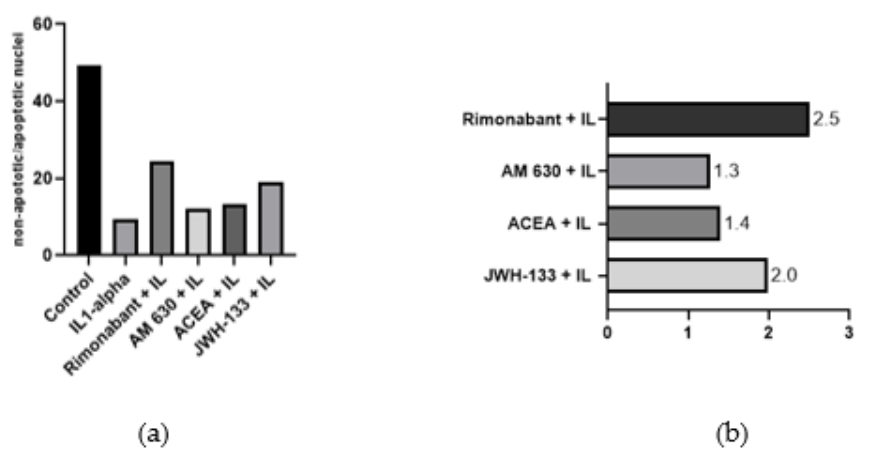
Figure 3. ( A ). Effect of rimonabant, AM630, ACEA and JWH-133 on IL-1 α -induced apoptosis in VSMCs. Magnification × 10. More condensed small cell nuclei with irregular form (blebbing) as well as more disintegrating cells were detected after IL-1 α stimulation ( B ). ( a ) The ratio of normal cell nuclei to apoptotic cell nuclei in VSMC. The higher the bar, the more normal VSMC could be found in the treatment group. ( b ) The relation of apoptotic ratio in the treatment group to the ratio of the IL-1 α -stimulated group. The resulting number expresses the factor of increased normal cell nuclei in comparison to the IL-1 α group.